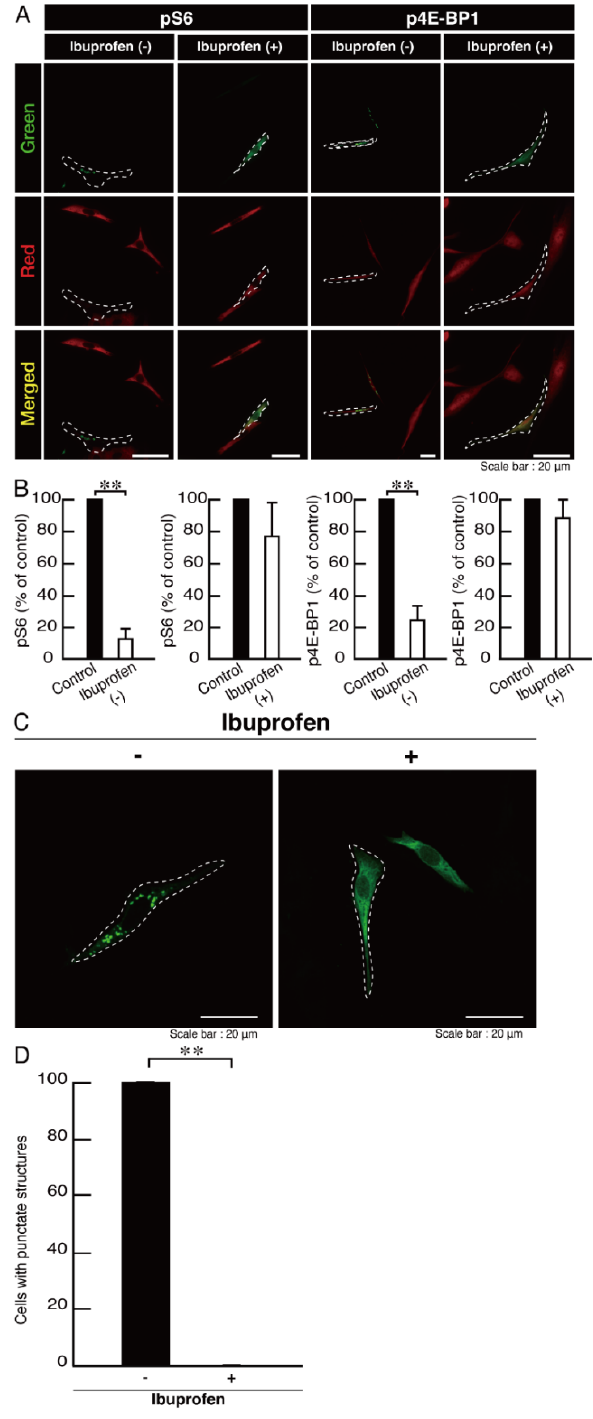
Figure 12. Ibuprofen improves phosphorylation levels of ribosomal S6 and 4E-BP1 proteins and aggregate-like punctate structures in cells harboring the mutants. ( A , B ) Cells harboring POLR3B (R550X) (green) in the presence or absence of ibuprofen were stained with an anti-(pS240 and pS244)ribosomal S6 protein (pS6) or anti-(pT37)4E-BP1 (p4E-BP1) antibody (red). Their phosphory- lation levels are shown statistically compared to those in their respective control cells under each image (** p < 0.01; n = 3 fields). ( C , D ) Cells harboring POLR3B (R550X) (green) were treated with or without ibuprofen. Percentages of cells with punctate structures were statistically assessed (** p < 0.01; n = 3